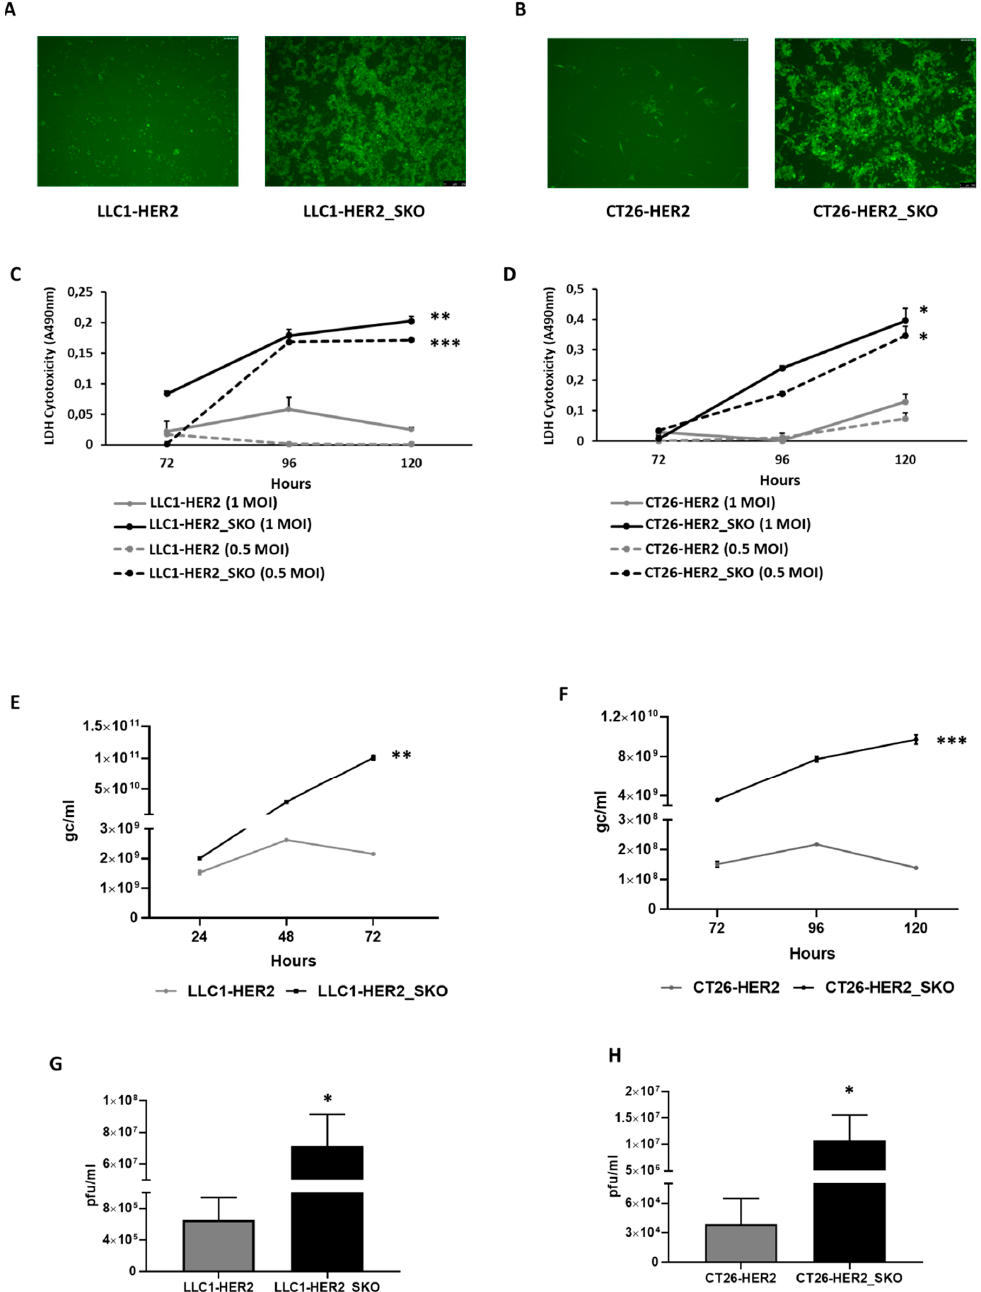
Figure 2 . Comparison of viral effectiveness in Sting knockout vs. parental wild-type cancer cell lines. ( A , B ) Spread of eGFP-encoding R-LM113 was evaluated by fluorescence microscopy in STING wild-type and knockout LLC1 (5×) ( A ) and CT26 (10×) ( B ) cell lines. ( C ) The lytic activity of R-LM113 was evaluated by extracellular LDH (lactate dehydrogenase) release in cell supernatants over the time course of infection (72, 96 and 120 h) in LLC1-HER2 (grey lines) and LLC1-HER2_SKO (black lines) at two different concentrations of viral particles (1 multiplicity of infection (MOI) continuous lines and 0.5 MOI dashed lines). ( D ) The same experiments performed in panel C were recapitulated in CT26-HER2 and CT26-HER2_SKO. All the infections were performed as biological replicates. The statistical significances for experiments described in panel c and d were calculated by Student’s t-test comparing MOI-matched Sting wild-type vs. knockout cell lines. The p -values were 0.00115 and 0.000219, respectively, for 1 and 0.5 MOI in panel C; 0.01583, 0.008543, respectively, for 1 and 0.5 MOI in panel D. ( E , F ) Evaluation of viral replication of R-LM113 in Sting wild-type and knockout LLC1 ( E ) and CT26 ( F ) infected with 0.3 PFU /